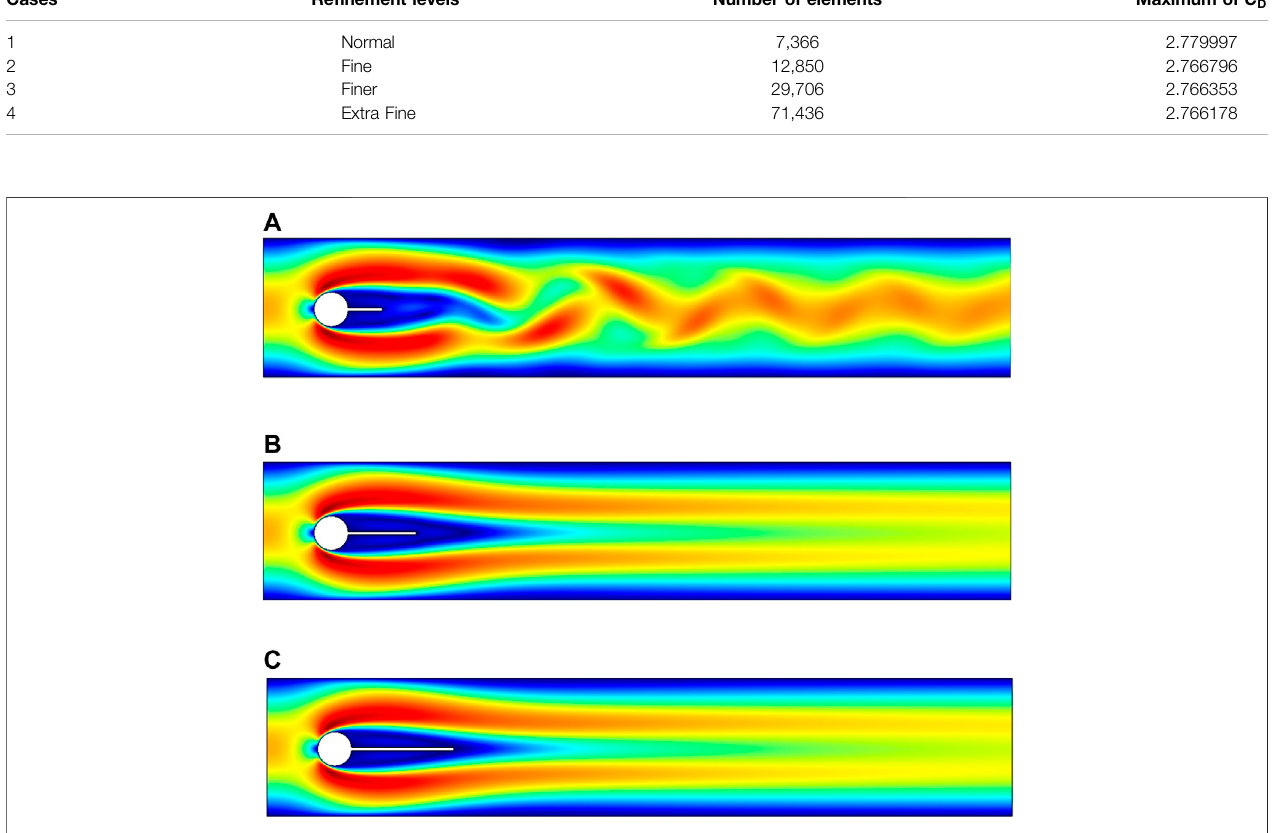
FIGURE 5 | In fl uence of an attached splitter plate on velocity, of length (A) L 1 = 0.1 , (B) L 2 = 0.2 , (C) L 3 = 0.3 with Re (cid:1) 100 at (cid:2) t (cid:1) 10 .